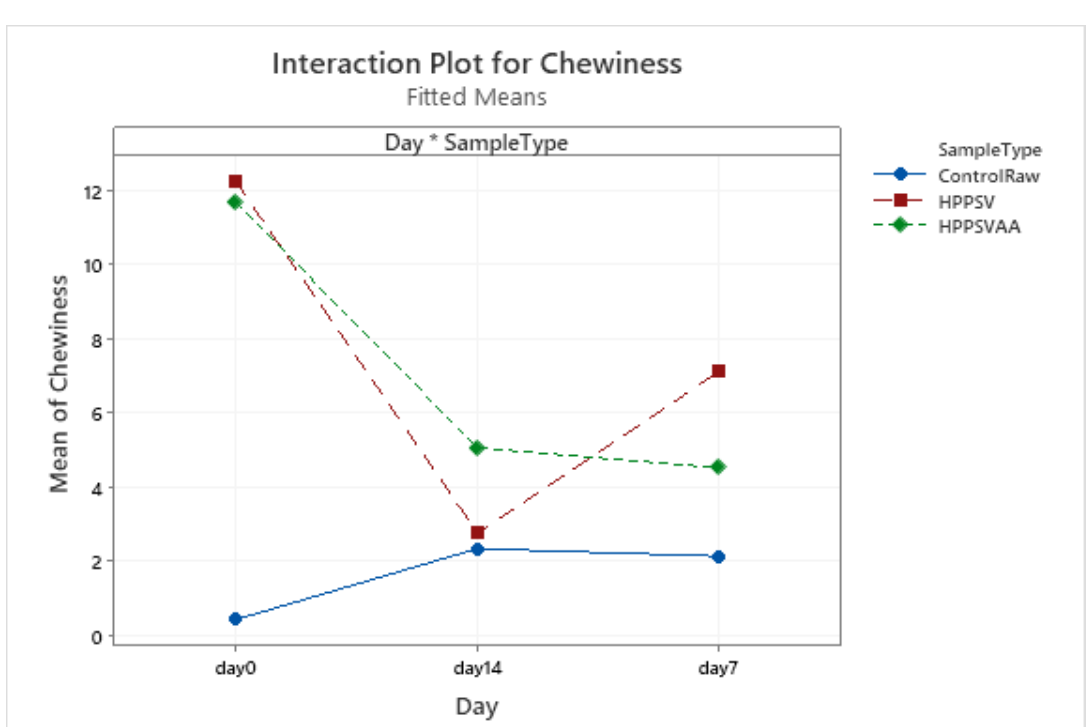
Figure A4 . Effect of treatments and storage time on the chewiness of veal patty (HPPSV: HPP- SVCOOK).